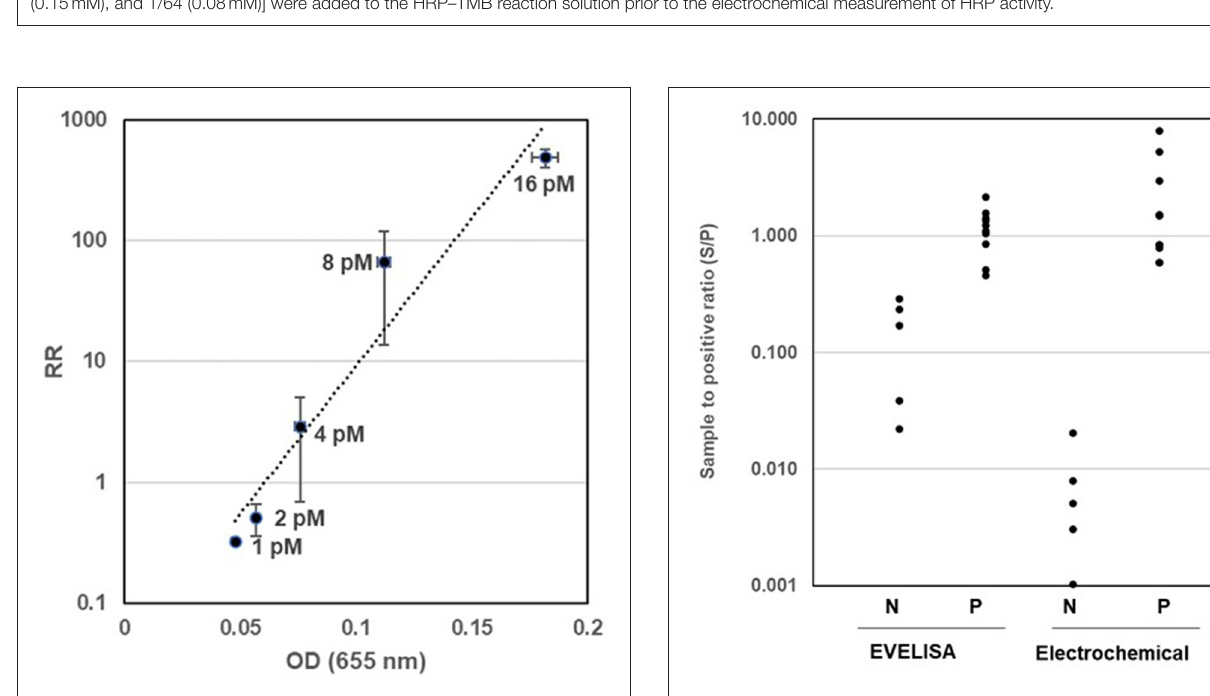
FIGURE 4 | Comparison of anti-MAP antibody detection using the Ethanol-Vortex ELISA test (EVELISA) and new electrochemical method. Serum samples from 5 JD-negative (N) and 10 JD-positive (P) samples were tested by the EVLISA and the electrochemical method. The experiment was conducted with two replicates. A similar result was obtained in a separate